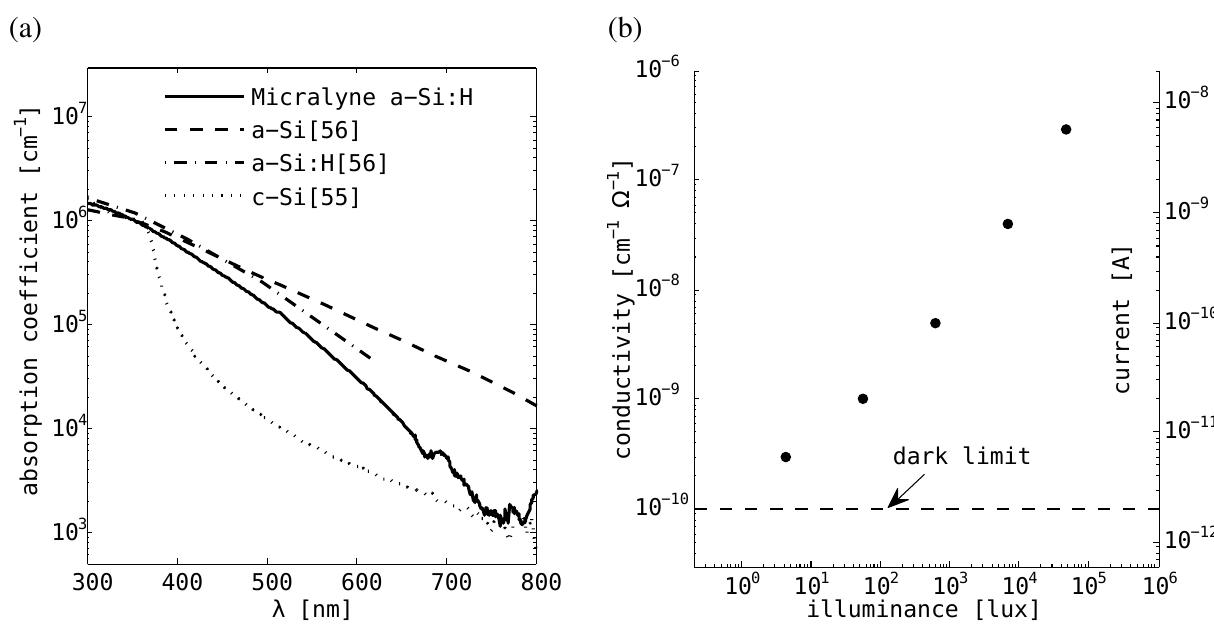
Figure 9. Optoelectronic properties of Micralyne a-Si:H films: (a) measured absorption coefficient as compared to literature values; and (b) film conductivity and estimated pixel current for varying surface